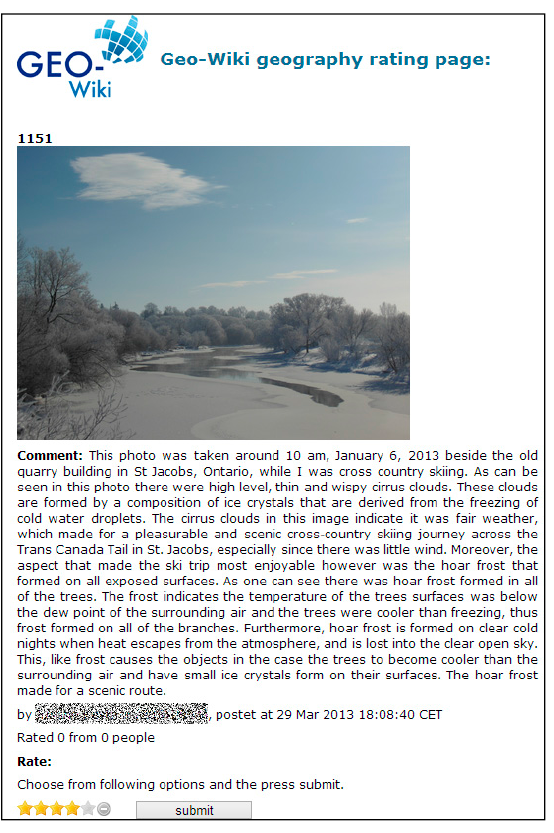
Figure 3. The rating page for an individual photo.